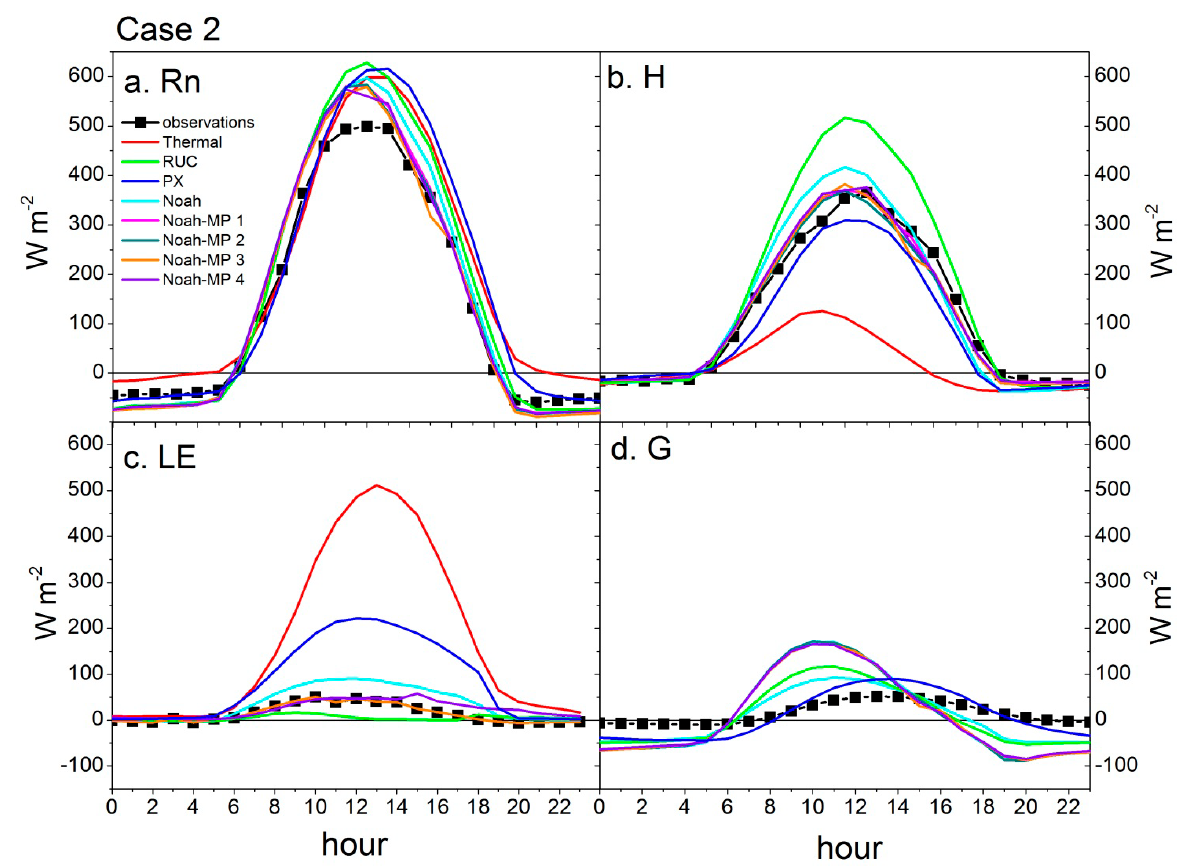
Figure 6. Mean diurnal plots of measured and simulated (a) net available energy (Rn), (b) sensible heat (H), (c) latent energy (LE), and (d) ground heat (G) fluxes for each LSM during Case 2 (July